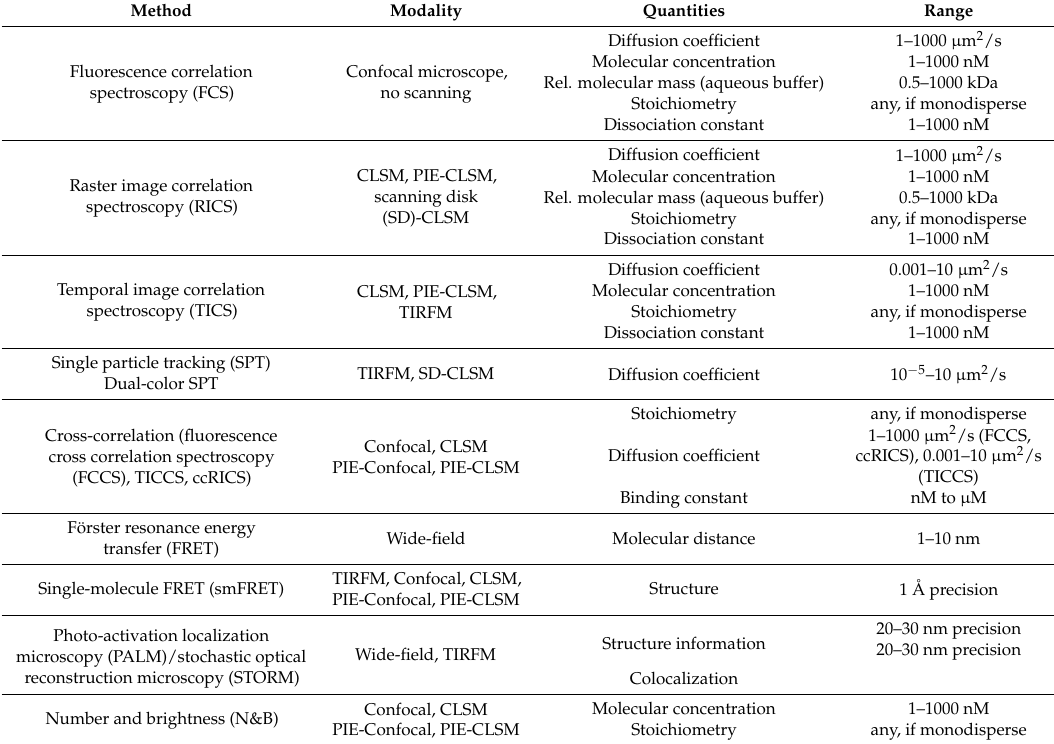
Table 1. List of quantitative fluorescence methods and the determined parameters. A full description of the listed modalities is provided in the Supporting